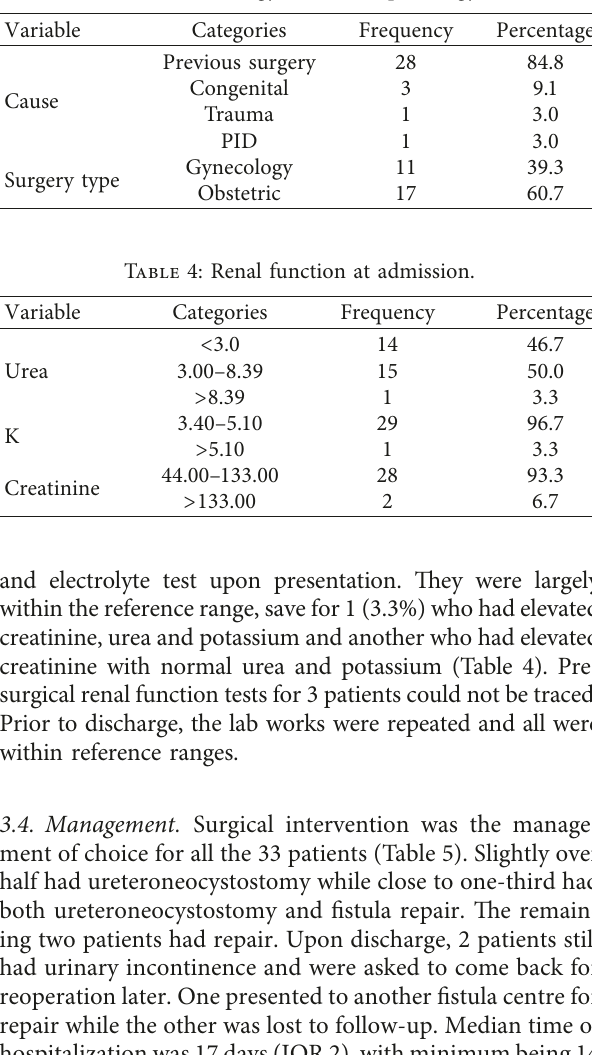
Table 5: Treatment